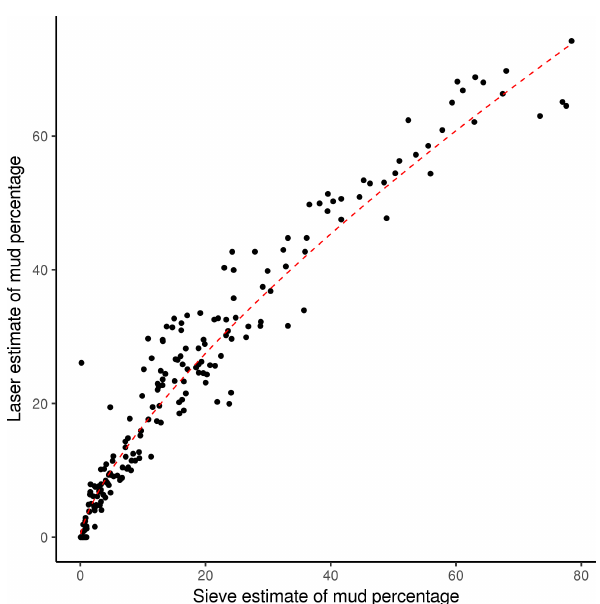
Figure 3. The relationship between mud estimated from laser and sieve methodology for the same samples. For estimates of car- bon and nitrogen content with only sieve-based estimates of mud content, we estimated what the mud percentage would be when calculated using laser methodology. The dashed red line shows this relationship (laser mud = 3.157 × (sieve mud) 0 . 7225 , p value: < 2 . 2 × 10 − 16 , r 2 = 0 .